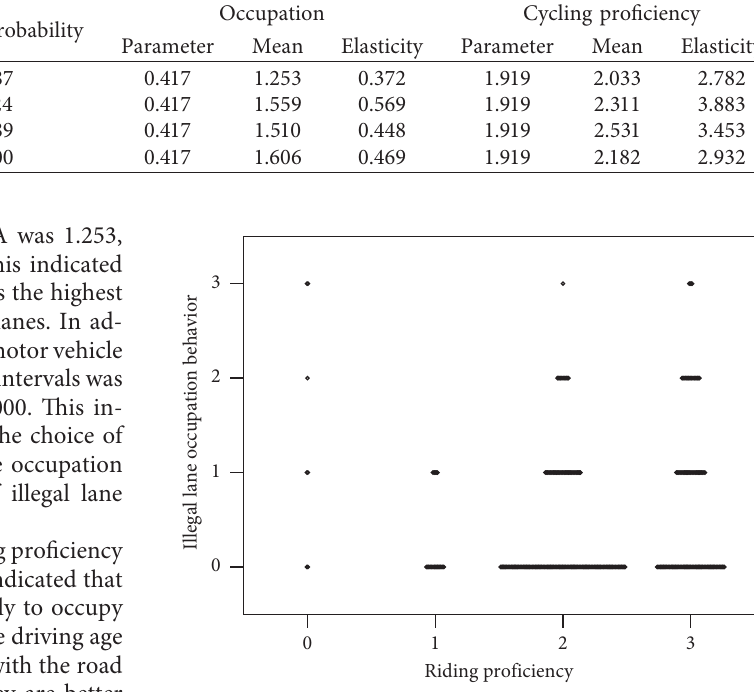
Figure 5: Relationship between riding proficiency and behavior of illegal lane